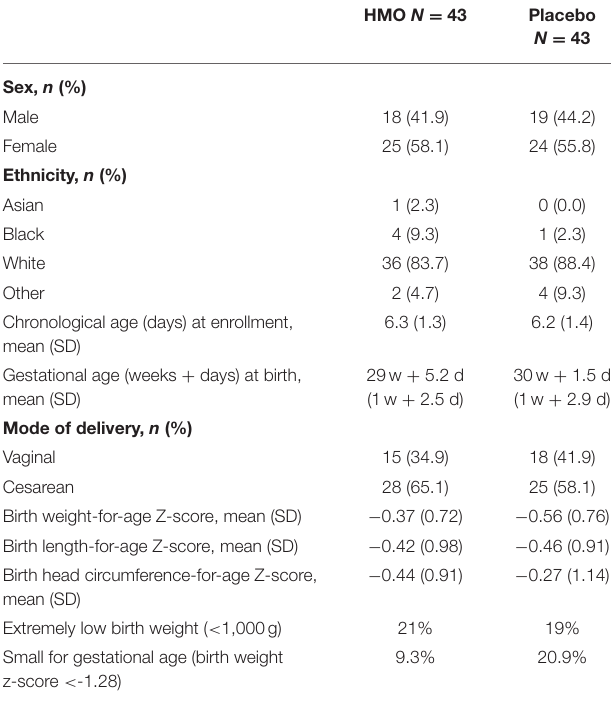
TABLE 1 | Infant characteristics by study arm, ITT population ( N =